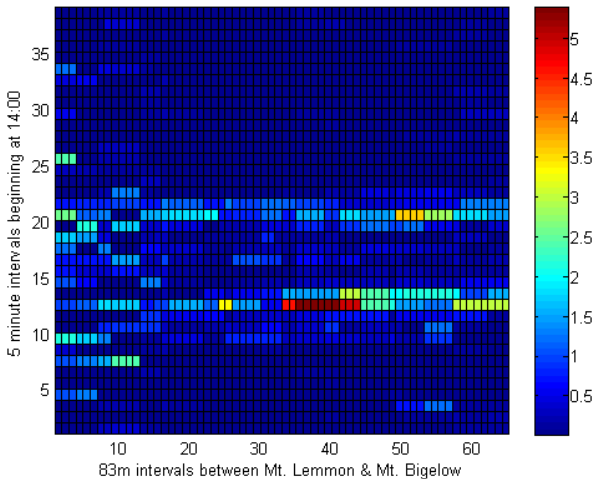
Fig. 15. Rainrate in mmh − 1 derived from the Tucson WSR-88 radar data via the standard Z - R relation. The x- and y-axes are the same as in Fig. (14). The units of the color scale are mmh − 1